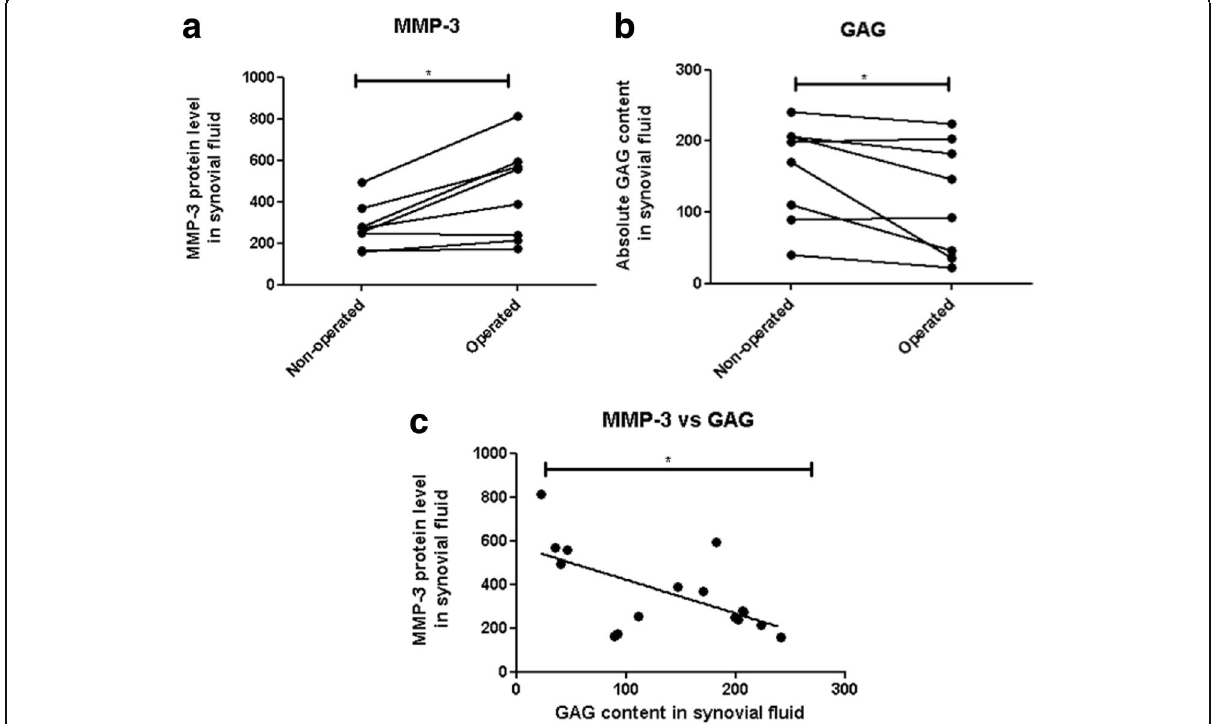
Fig. 2 MMP-3 is chronically upregulated and correlates with decreased GAG content in the synovial fluid of the operated knee in patients 40 years after meniscectomy. a MMP-3 and b GAG protein levels within the synovial fluid of patients 40 years post total meniscectomy in operated or non-operated knees ( n =8). c Correlation of absolute GAG levels plotted against absolute MMP-3 levels in the synovial fluid all knees ( n